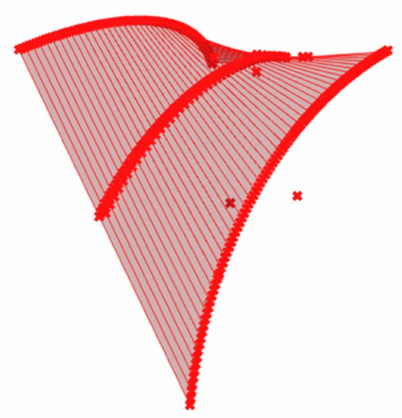
Figure 28. Smooth model of the upper surface of the shell roof being sought. Table 4. Parameters describing the subsequent shell folds in the transformed shell whose simplified smooth model is shown in Figure